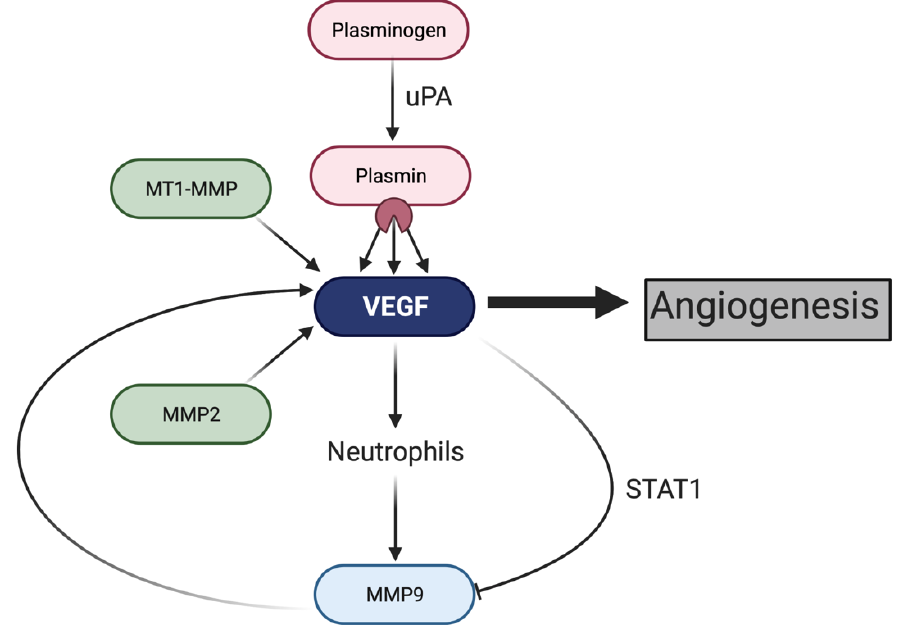
Figure 2. Effects of proteolysis on the VEGF pathway. Plasminogen, when cleaved by uPA into its active form plasmin, cleaves VEGF into different isoforms for multiple biological functions [97]. VEGF recruits neutrophils, which express MMP-9, which encourages VEGF production in a positive feedback loop [92,93]. MT1-MMP and MMP-2 also promote VEGF-mediated angiogenesis [83,87].